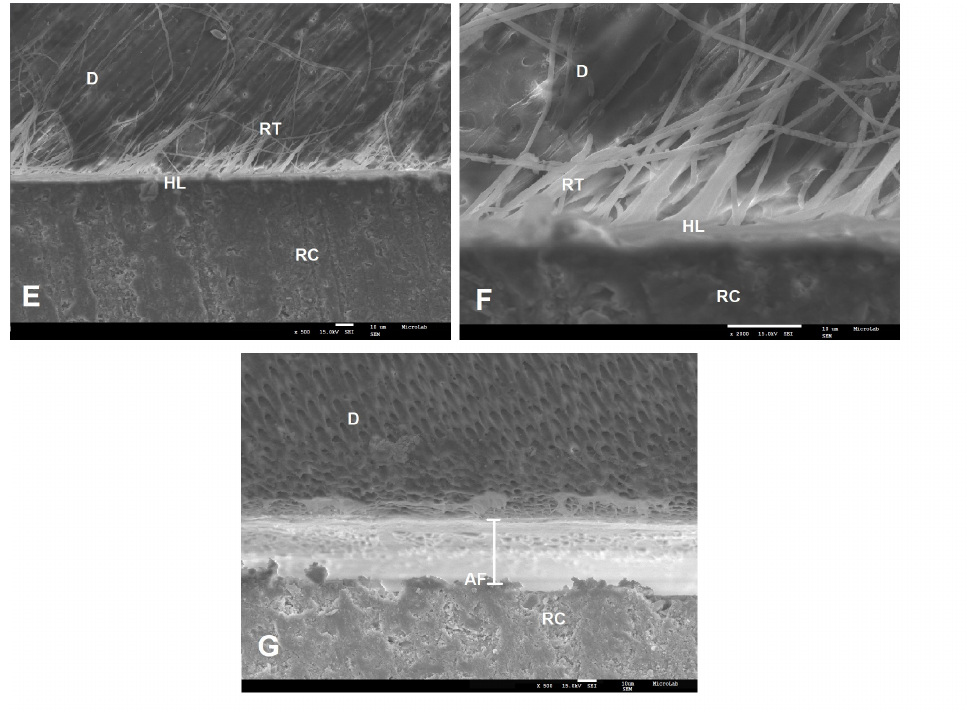
Figure 4. SEM micrographs of bonding interface of the experimental adhesives when SE was applied. Magnification of 500 × ( E , G ) and 2000 × ( F ) were used. E and F —AE1 with 10.4 µ m of HL thickness; ( G )—AE2. RC—resin composite; D—dentin; HL—hybrid layer; RT—resin tags; AF—adhesive